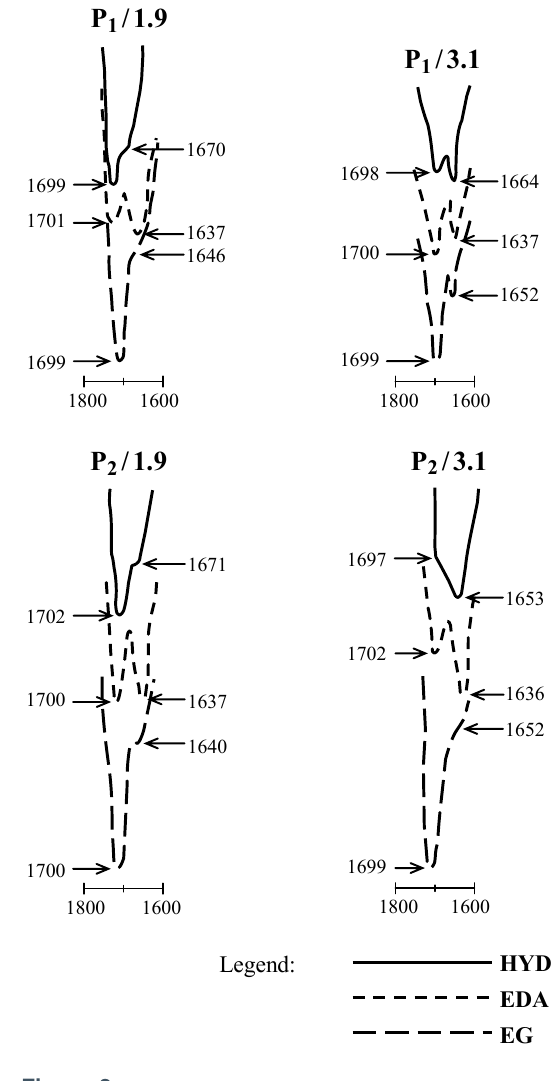
Figure 2. Profile of the absorption bands and the respective fre- quency values in cm − 1 corresponding to carbonyl groups of cast films from wPUU, chain-extended with hydrazine (HYD) and ethylenediamine (EDA), and wPU, chain- extended with ethylene glycol (EG), with variation in the length of soft segments (P 1 and P 2 ) and in the rigid seg- ments content (NCO/OH = 1.9 and